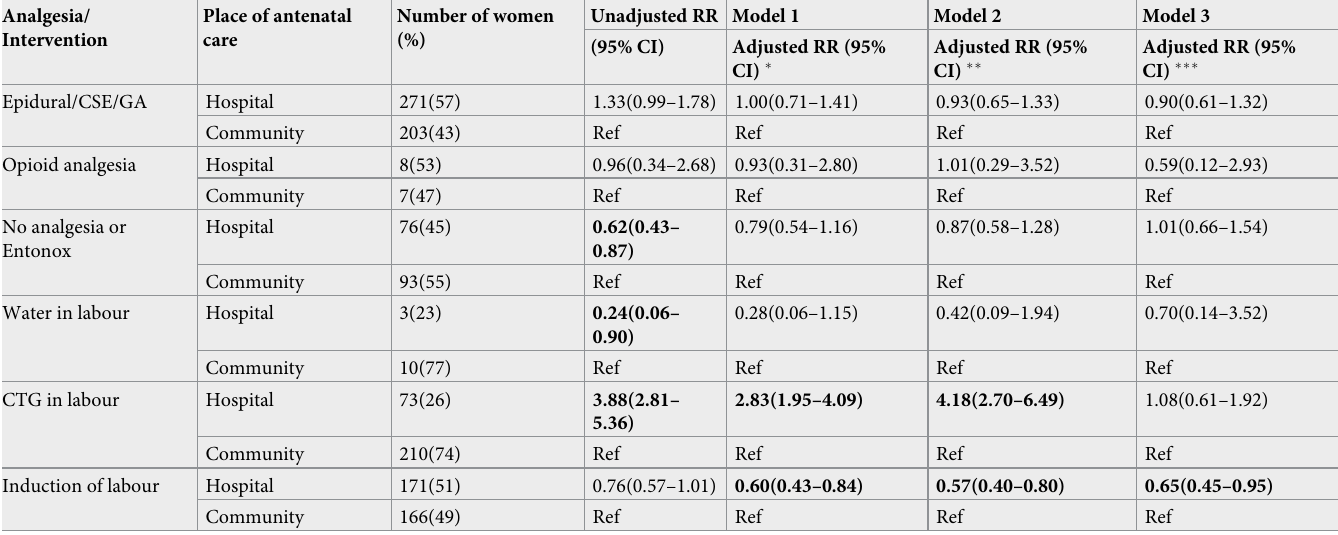
� Model 1: Adjustment for demographics ethnicity, age, parity, IMD score, social risk and medical risk factors at booking and onset of labour. �� Model 2: Model 1 + adjustment for model of care. ��� Model 3: Model 2 + adjustment for service provider attended.